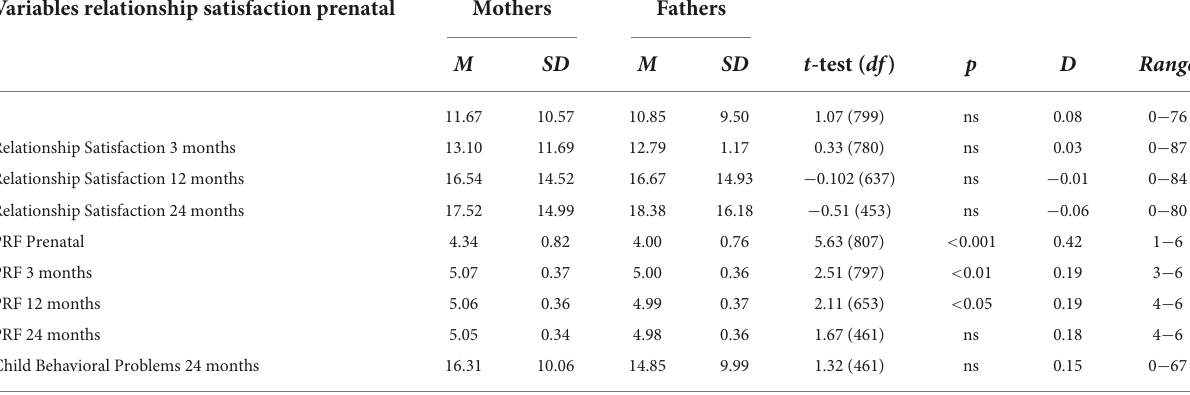
TABLE 2 Means and standard deviations of the study variables for mothers and